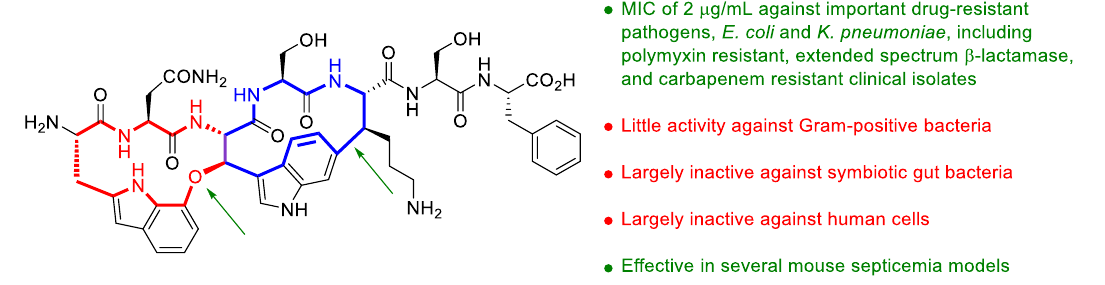
Figure 11. Chemical structure of darobactin, featuring two fused rings (in red and blue) with an unprecedented aromatic-aliphatic ether linkage between two tryptophans and a unique tryptophan-lysine bond between two inactivated carbons (green arrows). Conflicts of Interest: The authors declare no conflict of interest.